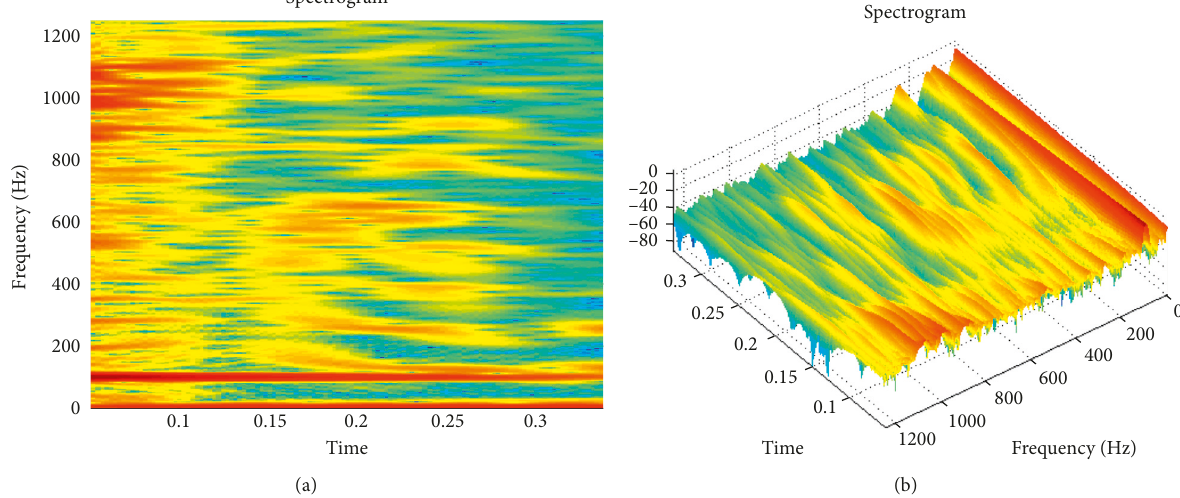
Figure 4: Spectrogram of a measured acceleration signal. (a) 2D plot and (b) 3D plot.